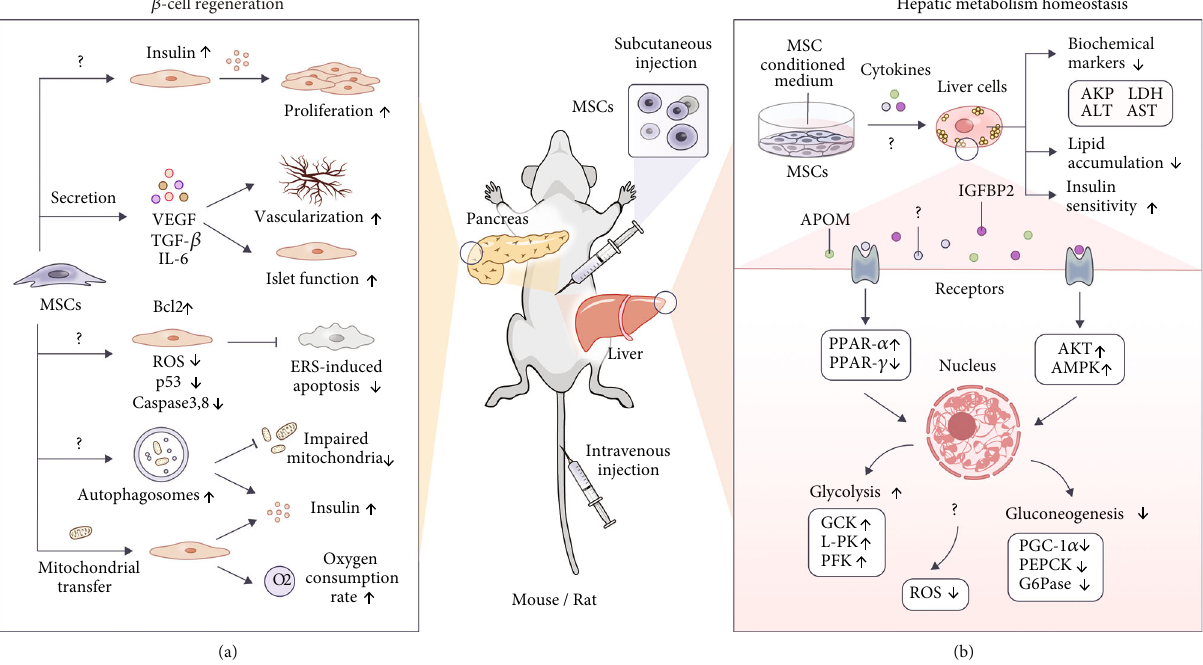
Figure 1: (a) Possible mechanisms of action for MSCs to promote islet regeneration. MSCs might initiate endogenous insulin production and stimulate the proliferation of β -cells. Various bioactive molecules secreted by MSCs, such as VEGF, TGF- β , and IL-6, can lead to enhanced vascularization and islet function. Besides, mitochondria of MSCs could be transferred to β -cells under hypoxia conditions to enhance the insulin secretion rate. MSCs show their antiapoptotic e ff ect by downregulating ROS, caspase 3, caspase 8, and p53 and upregulating Bcl2. MSCs are capable of enhancing the formation of phagosomes, leading to the improved clearance of impaired mitochondria and the increased number of insulin granules. (b) Possible mechanisms of action for MSCs to in fl uence hepatic metabolic homeostasis. MSCs can reduce the number of impaired mitochondria and systemic ROS levels to prevent liver metabolic imbalance. Upon MSC administration, PPAR- α was upregulated while PPAR- γ was downregulated. The expression of enzymes involved in hepatic glycolysis (GCK, L-PK, and PFK) is elevated, while the enzymes involved in gluconeogenesis (PGC-1 α , PEPCK, and G6Pase) are reduced. In addition, MSCs can activate AKT and AMPK signaling pathways, which play a key role in cell metabolism. MSCs could signi fi cantly lower disordered biochemical markers of liver function caused by HFD, for instance, AKP, LDH, ALT, and AST, as well as reduce hepatic lipid accumulation and ameliorate insulin sensitivity. Abbreviations: VEGF: vascular endothelial growth factor; TGF- β : transforming growth factor- β ; IL-1Ra: interleukin-1 receptor agonist; ER: endoplasmic reticulum; ROS: reactive oxygen species; AKT: protein kinase B; AMPK: AMP-activated protein kinase; HFD: high-fat diet; GCK: glucokinase; L-PK: liver pyruvate kinase; PFK: 6- phosphofructo-1-kinase; PGC-1 α : peroxisome proliferator γ -activated receptor coactivator 1- α ; PEPCK: phosphoenolpyruvate carboxykinase; G6Pase: glucose-6-phosphatase; AKP: alkaline phosphatase; LDH: lactate dehydrogenase; ALT: alanine aminotransferase; AST: aspartate